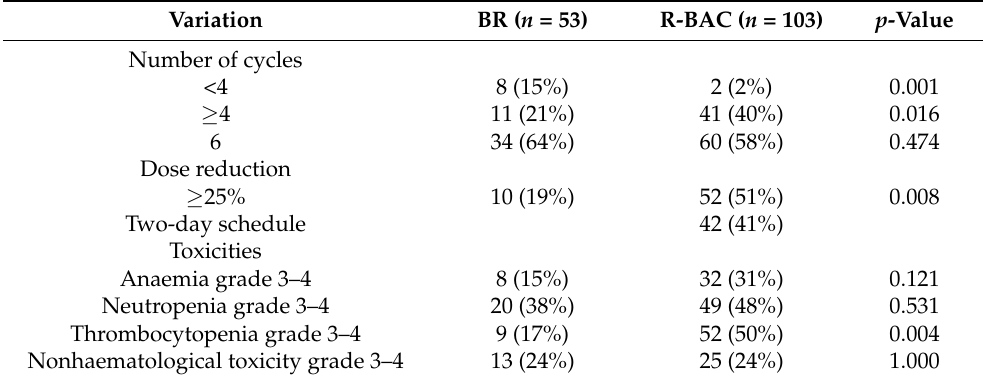
Table 2. Administered cycles, premature interruptions, and